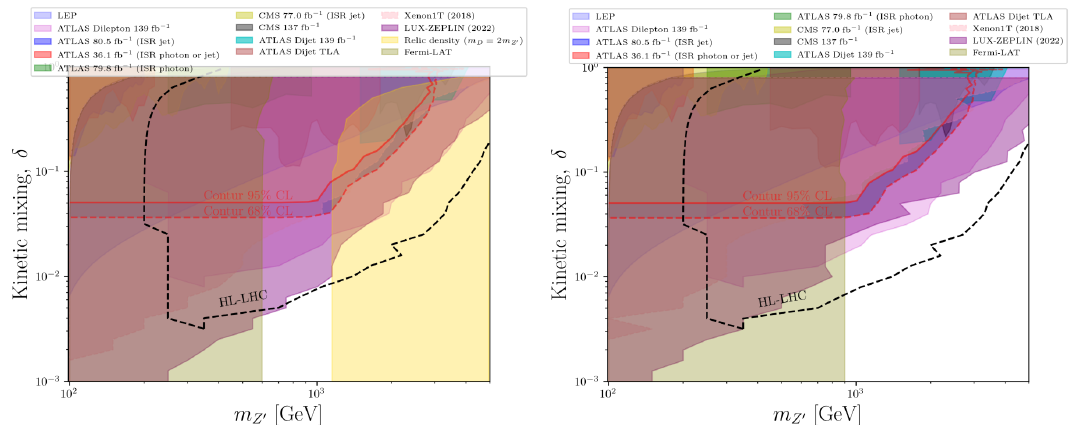
Figure 2 . Exclusion limits from LHC analyses, LEP, DM relic density, direct and indirect detection experiments in the kinetic mixing- Z 0 mass plane for m D = 2 m Z 0 (left panel) and m D = 1 . 5 m Z 0 (right panel). The dashed black contour shows the projected reach of HL-LHC in the dilepton channel. Note that the region bordered by a red solid (dashed) line represents the 95% (68%) CL from Contur